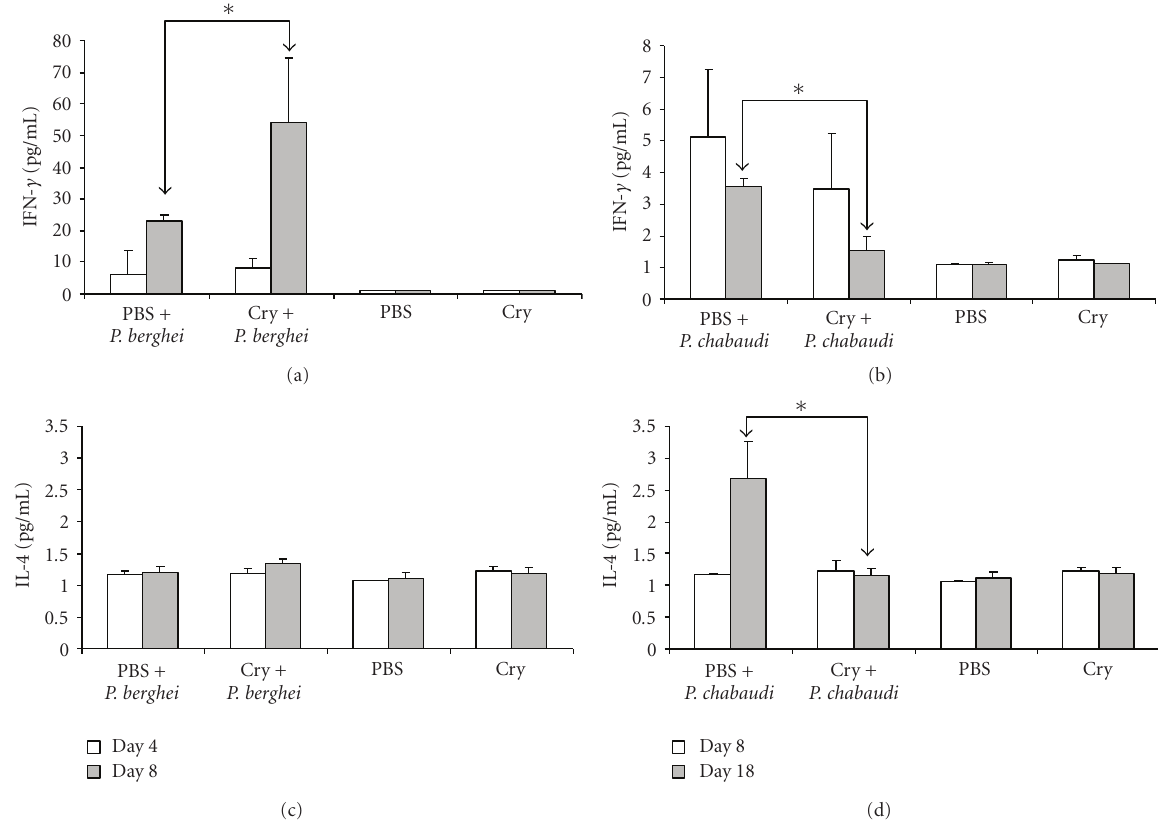
Figure 4: E ff ect of Cry1Ac on serum cytokines in Plasmodium -infected mice.Mice were treated with Cry1Ac protoxin or PBS once weekly for four weeks. One day after the last injection, mice were infected with P. berghei ANKA or P. chabaudi AS. On days 4 and 8 PI (a and c) or days 8 and 18 PI (b and d), three mice from each group were killed, their sera was separated from peripheral blood and the levels of the cytokines IFN- γ (a and b) and IL-4 (c and d) were measured by cytometric bead array. Data are representative of two separate experiments. Asterisks indicate statistically significant di ff erences between the indicated